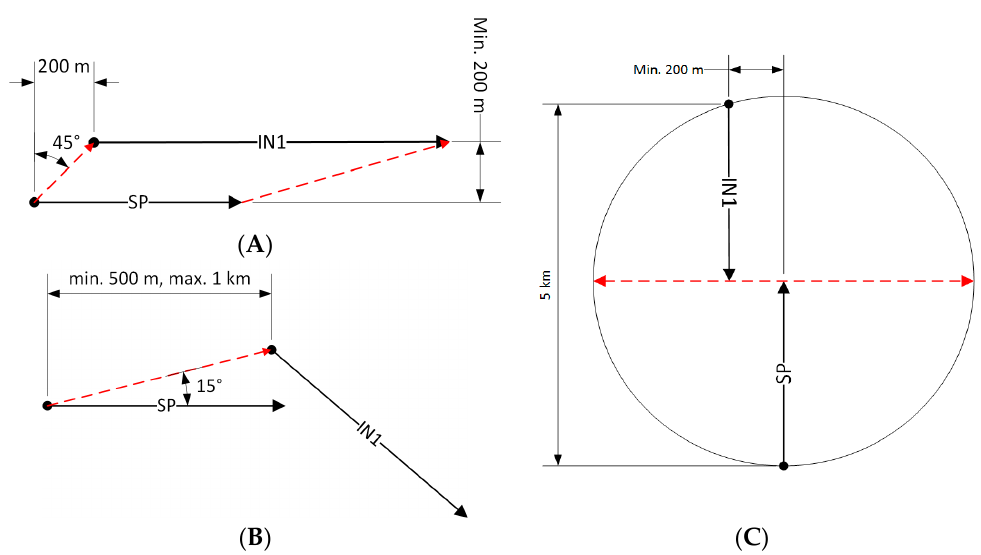
Figure 5. Intruder detection scenario on a parallel course ( A ); intruder detection scenario on a collision course, convergent value courses ( B ) and opposite courses ( C ); IN1—intruder number 1, SP—IDAAS equipped airplane.